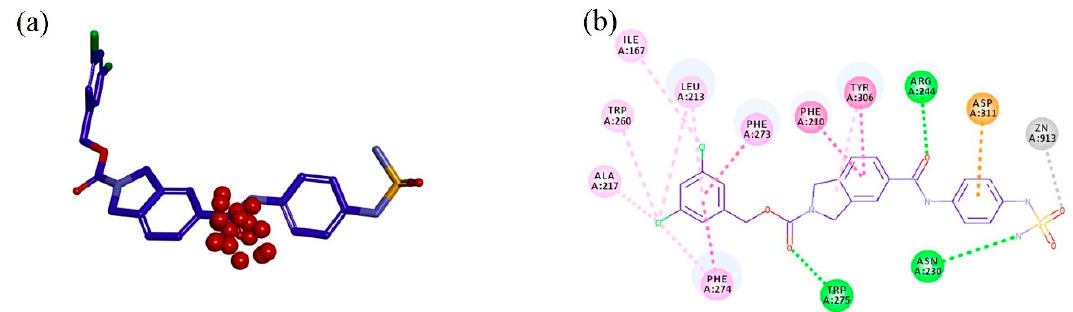
Figure 5. ( a ) Binding mode of compound 3 (cyan stick model) overlapped with TWNs of the L’ region. ( b ) 2D interaction diagram of compound 3 (purple line model). Hydrogen bond, pi-anion and hydrophobic interactions with the active site residues are shown as green, orange and pink dashed lines, respectively. The electrostatic interaction with a catalytic zinc ion is represented by the gray dashed line.